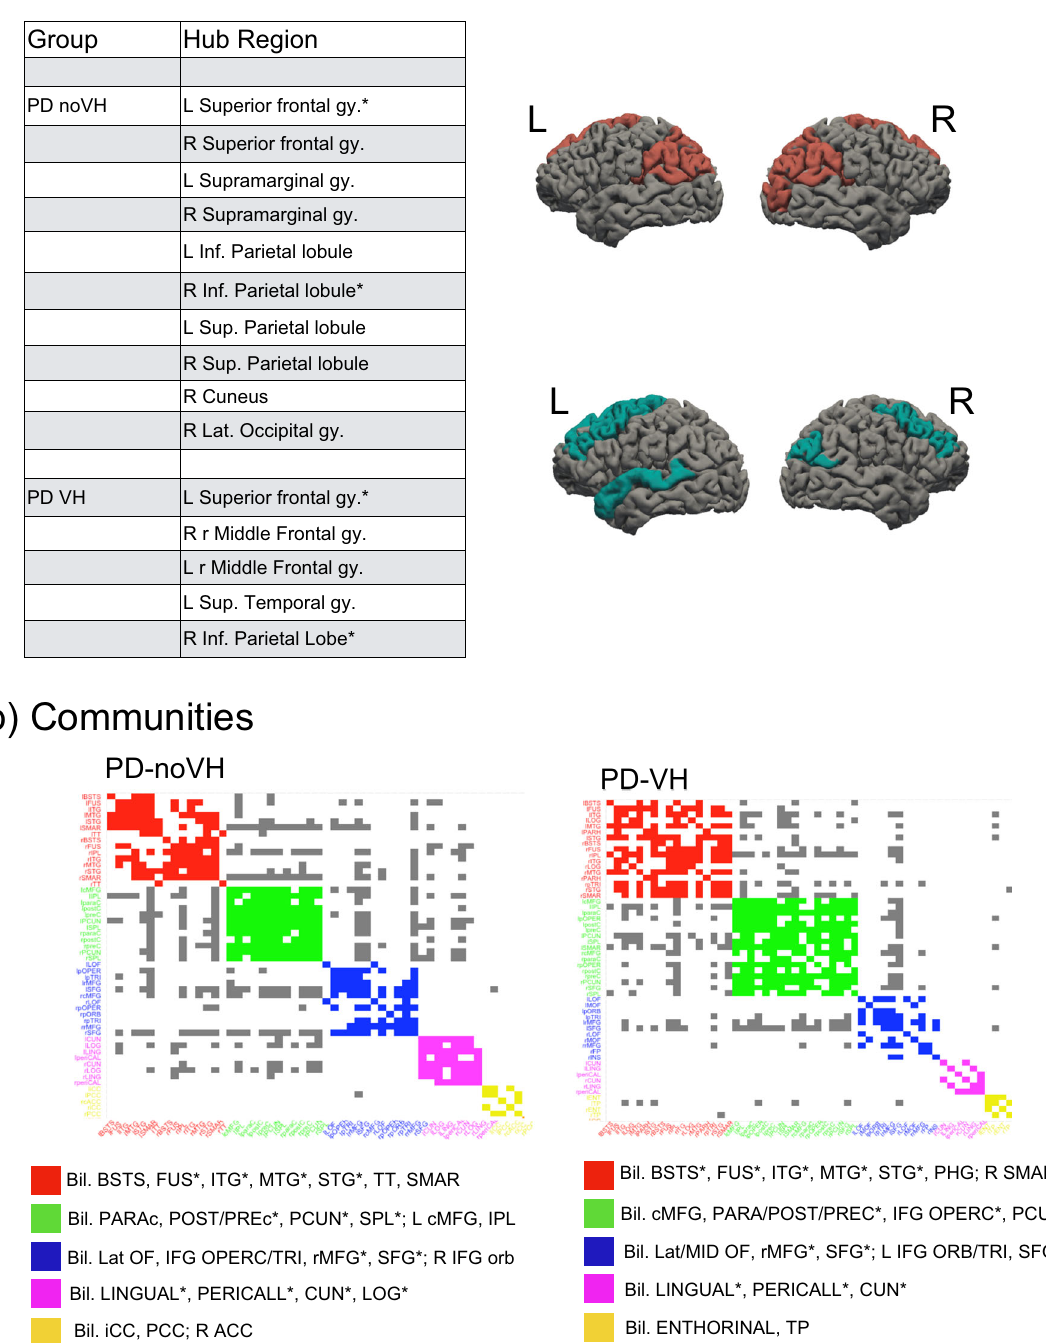
Fig. 6 Hubs and communities: cortical thickness. a Hubs identi fi ed based on ef fi ciency, betweenness centrality and degree. Regions marked with a * are common hubs for both VH and noVH. b Communities identi fi ed for each group. Legend: red = 1st community, green = 2nd, blue = 3rd, pink = 4th, yellow = 5th. Only the fi rst fi ve communities are represented as they are the most informative ones. The regions identi fi ed for that same community also in the surface area analysis are marked with a *. BSTS = banks superior temporal sulcus, IPL inferior parietal lobule, SPL superior parietal lobule, LOG lat. Occipital gyrus, MTG middle temporal gyrus, STG superior temporal gyrus, cMFG caudal middle frontal gyrus, PHG parahippocampal gyrus, paraC paracentral gyrus, preC precentral gyrus, postC postcentral gyrus, IFG inferior frontal gyrus, SFG superior frontal gyrus, SMAR supramarginal gyrus, FP frontoparietal thickness, TT temporal transverse, FUS fusiform gyrus, CUN